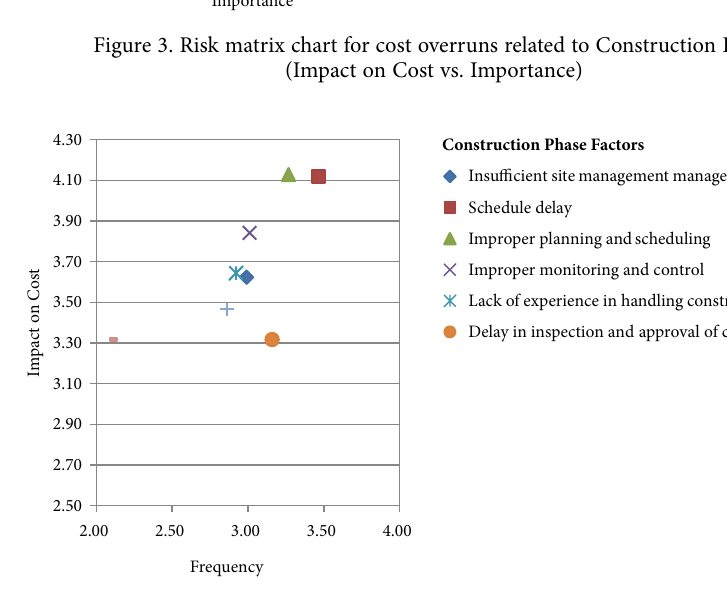
Figure 4. Risk matrix chart for cost overruns related to Construction Phase (Impact on Cost vs.